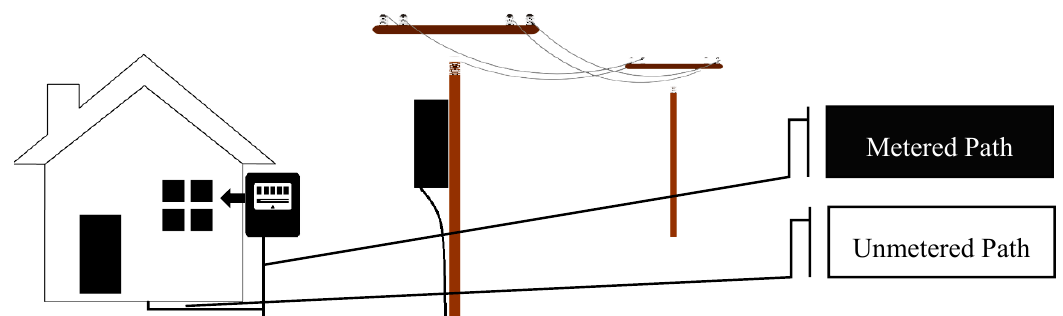
Figure 14. Illustration of energy theft through unmetered circuits.